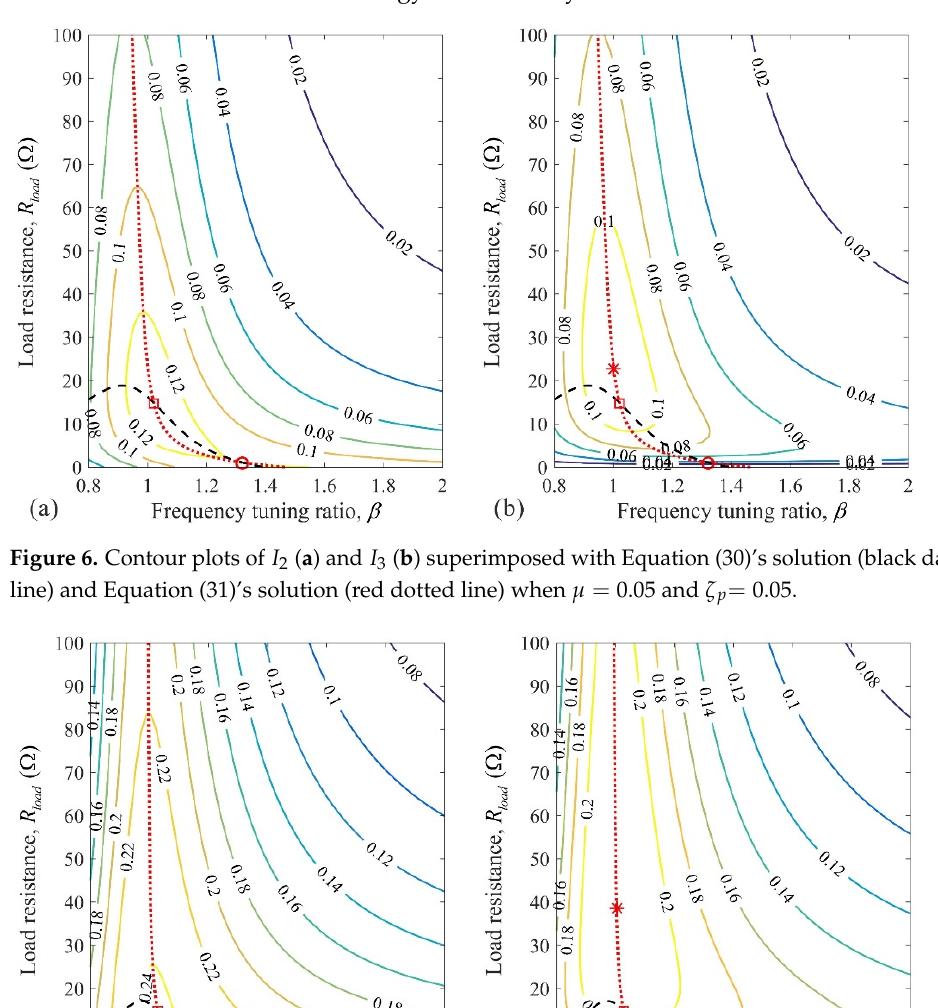
Figure 7. Contour plots of I 2 ( a ) and I 3 ( b ) superimposed with Equation (30)’s solution (black dashed line) and Equation (31)’s solution (red dotted line) when µ = 0.05 and ζ p =